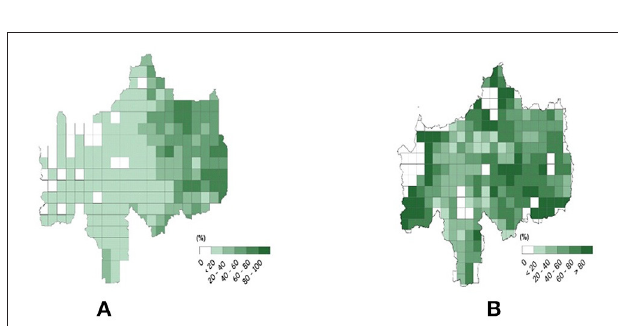
FIGURE 2 | Delineated suitable lands for agriculture at different land suitability levels for cereals.